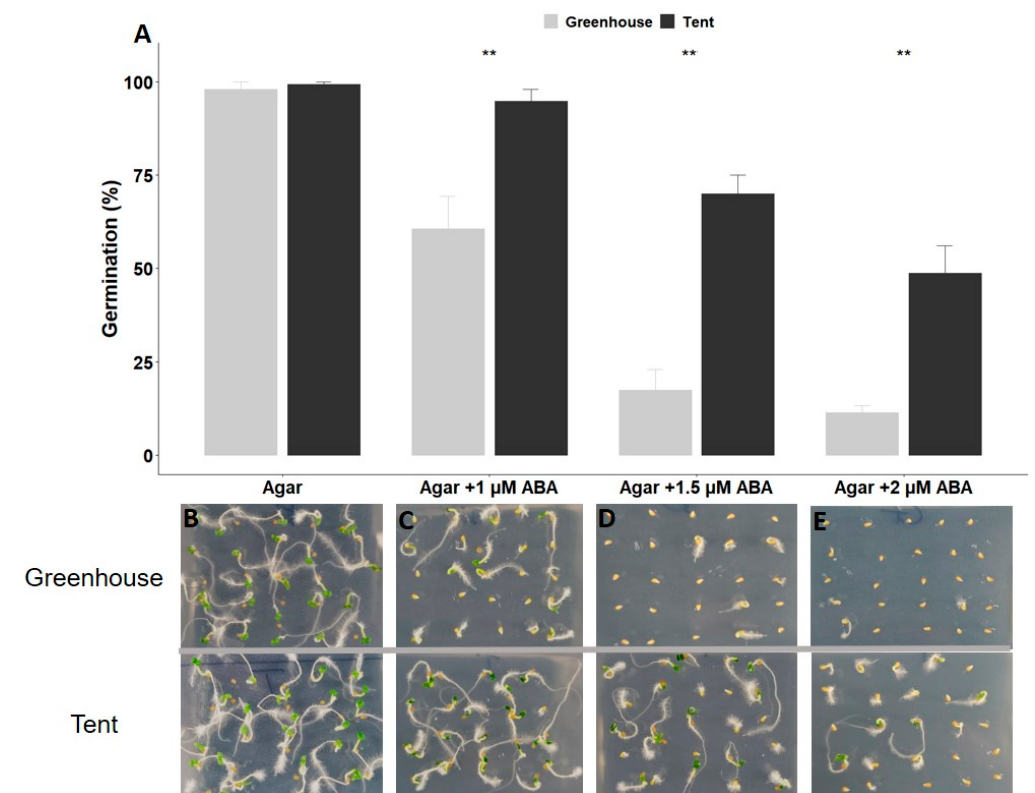
Figure 2. Germination response of petunia seeds from greenhouse or tent plants to abscisic acid (ABA) treatment. ( A ) Germination percentage of seeds from plants grown in two maternal environments at different concentrations of ABA. ( B ) Representative images of seed germination on a 1% agar plate without ABA or with different concentrations of ABA ( C – E ). The percentage of germination was recorded after a 7-day imbibition. Six replications, with 25 seeds per replication ( n = 150 total), from greenhouse or tent plants were applied to each treatment. The vertical bars represent the mean ± standard error. ** Significant difference between seeds from greenhouse and tent plants under the same germination condition at p < 0.01 ( t -test).